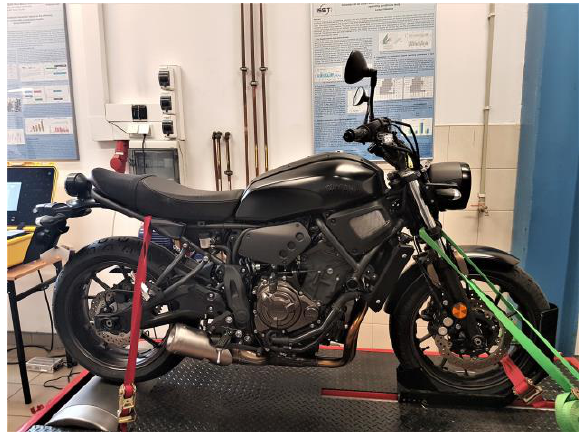
Fig. 1. Picture of the tested motorcycle along with the measuring apparatus on the designated dynamometer